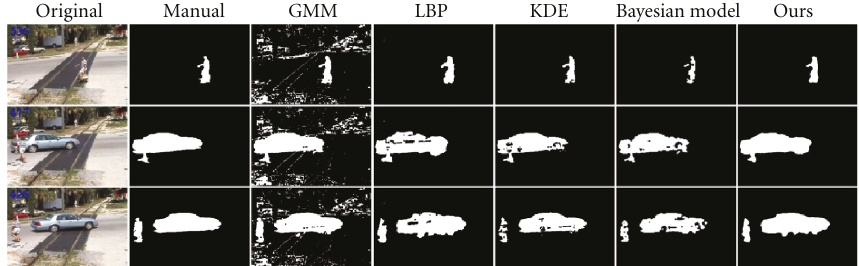
Figure 7: Qualitative comparison results of the five BGS algorithms on the Camera Jitter sequence. The first column contains the original video frames. The second column contains the corresponding ground truth frames. The last five columns contain the detection results of the GMM, LBP, KDE, Bayesian Model, and our method, respectively.